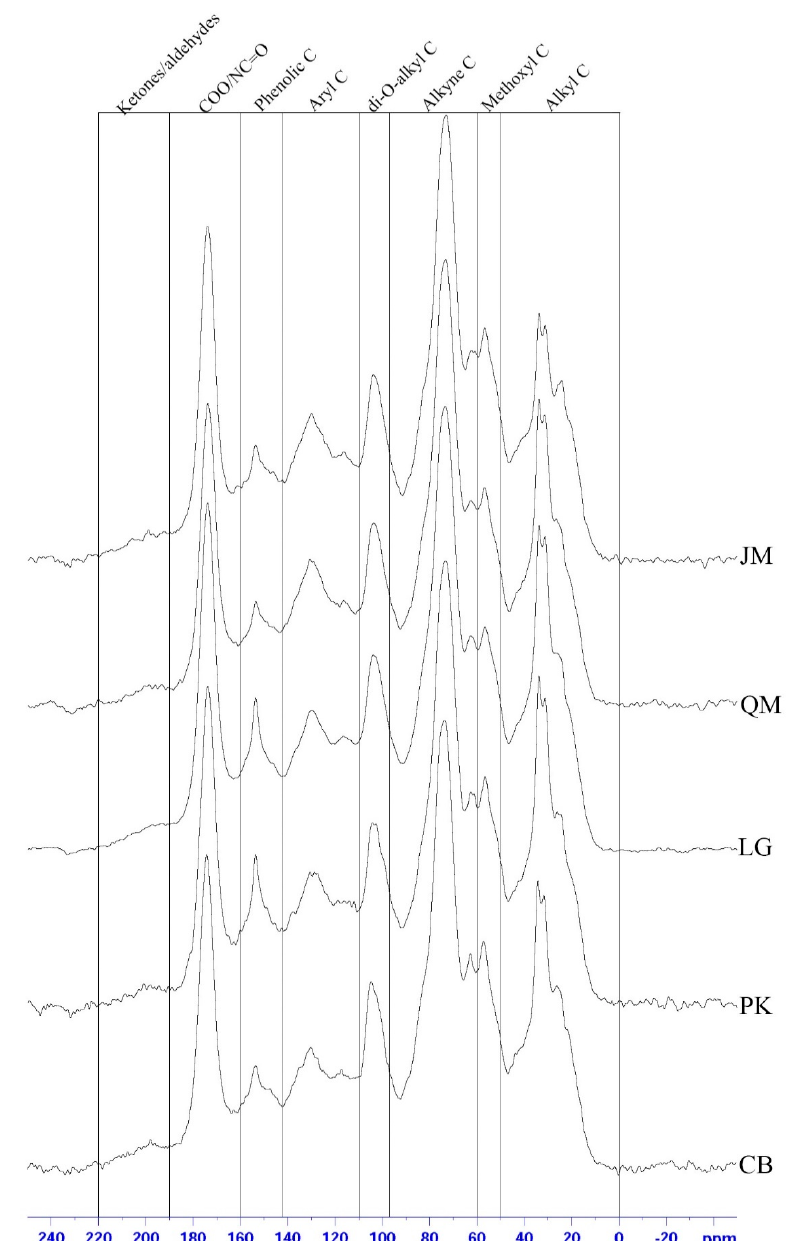
Figure 2. Solid-state 13 C NMR spectrogram of SOC. Carbonyl C (0–45 ppm); O-alkyl C (45–110 ppm), aromatic C (110–160 ppm) and carbonyl C (160–220 ppm). LG: Larix gmelinii Rupr.; PK: Pinus koraiensis Sieb.; CB: Conifer-broadleaf forest; JM: Juglans mandshurica Maxim.; QM: Quercus mongolica Fisch..